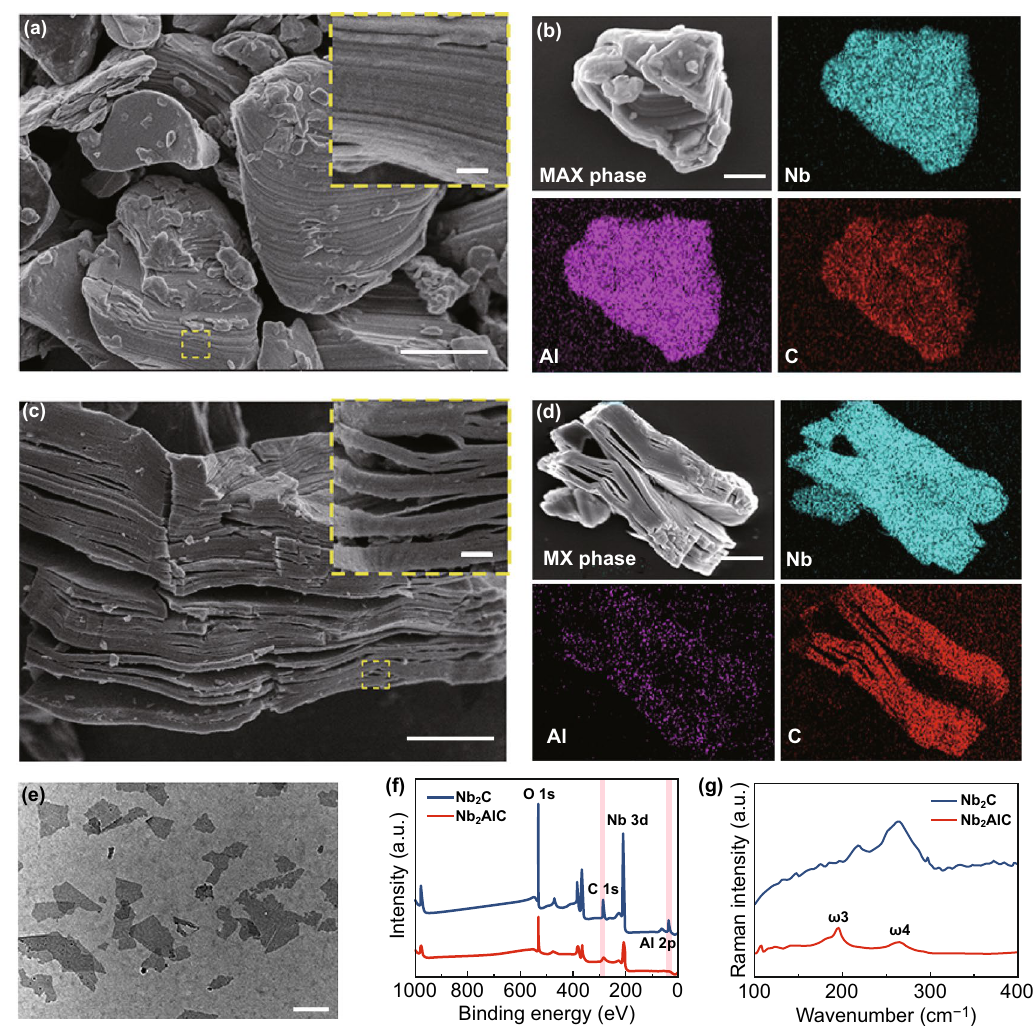
Fig. 1 Fabrication and characterization of ultrathin 2D Nb 2 C MXene NSs. a , b SEM images of Nb 2 AlC ceramics with corresponding element mapping (Nb, Al and C). c, d SEM images of multilayered Nb 2 C MXene and the corresponding element mapping (Nb, Al and C). e TEM image of one-layered or few-layered Nb 2 C MXene NSs. f X-ray photoelectron spectroscopy (XPS) spectra of Nb 2 AlC bulk and Nb 2 C NSs. g Raman spectra of